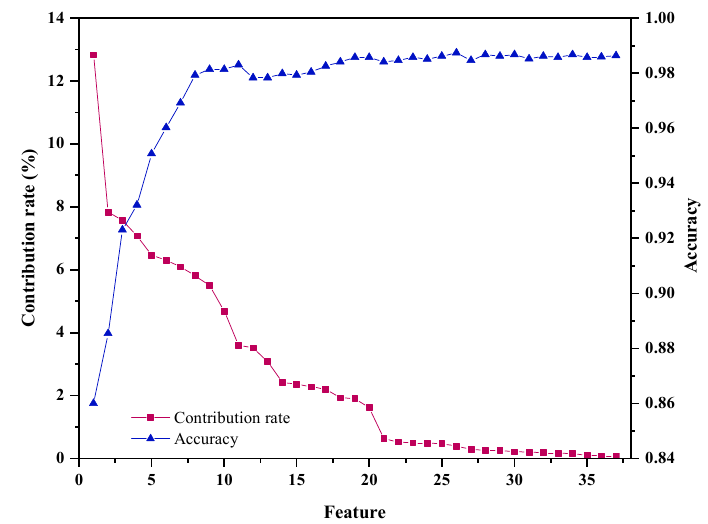
Figure 5. Feature contribution rate and its impact on accuracy.